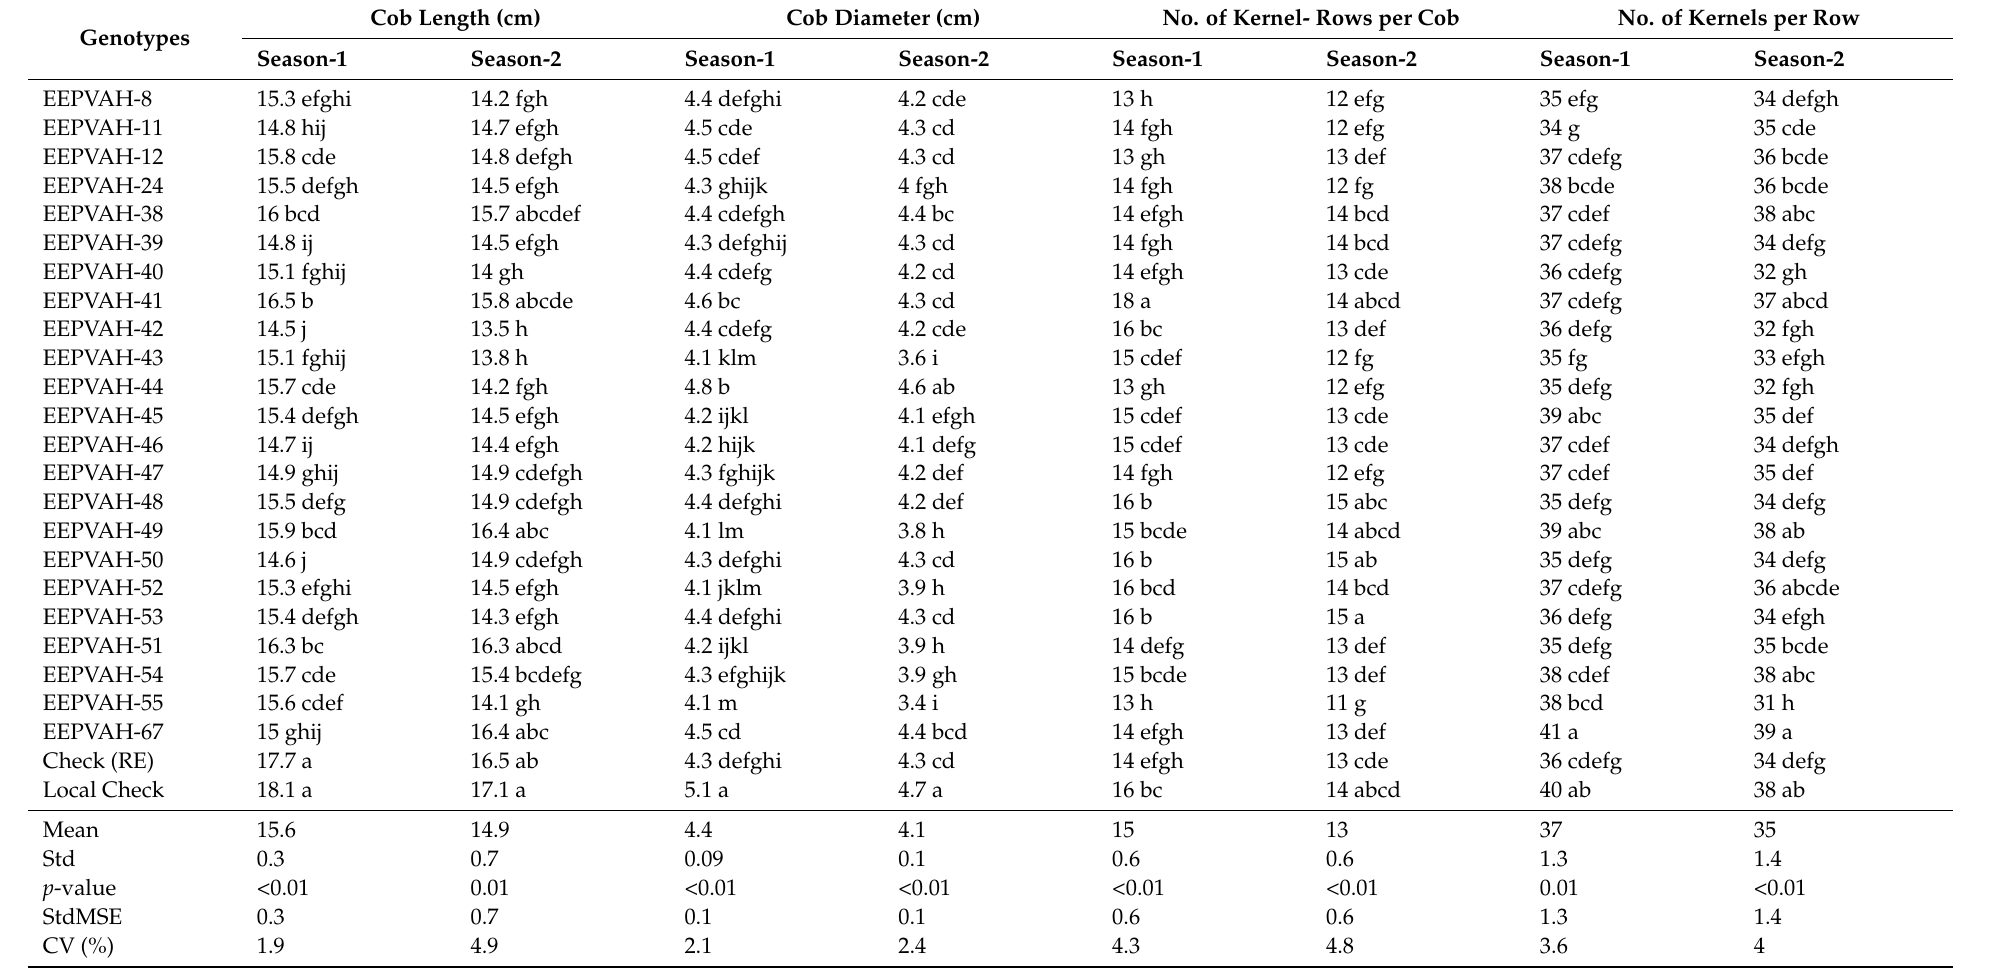
Table 6. Cob characteristics recorded in provitamin A biofortified maize genotypes from the two contrasting